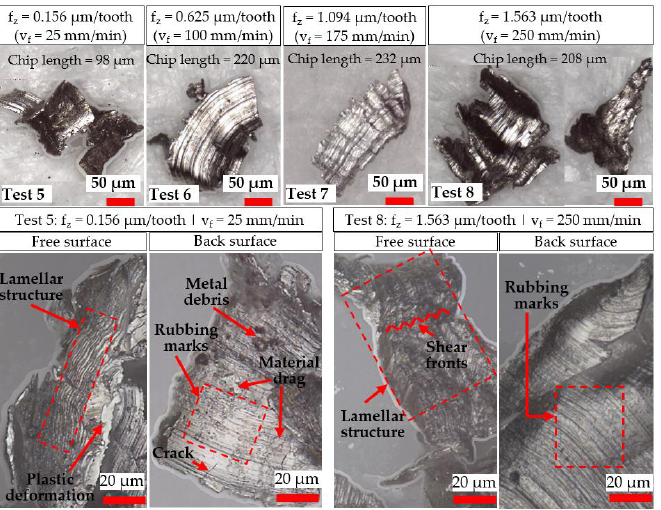
Figure 6. Evaluation of chip morphology from tests performed using Ø 1 mm end-mills.